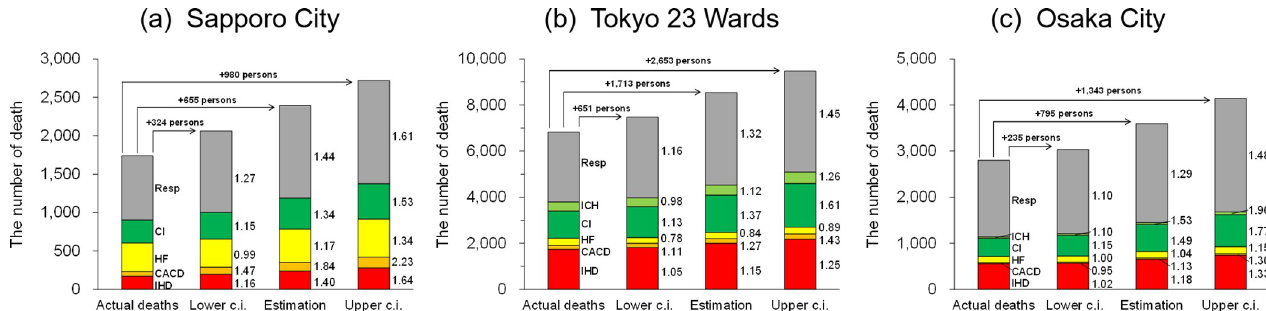
Fig 6. Estimated increases in death of each disease in April–December 2020 if the COVID-19 pandemic had not occurred. The results of acute ischemic heart disease (IHD) (red), cardiac arrhythmia and conduction disorder (CACD) (orange), heart failure (HF) (yellow), cerebral infarction (CI) (green), intracerebral haemorrhage (ICH) (light green), and respiratory diseases (Resp) (grey) are provided in (a) Sapporo, (b) Tokyo, and (c) Osaka. Here, only temperature-sensitive months (as indicated in Tables 2 and 3) are evaluated in each disease in the same manner as in Fig 5.